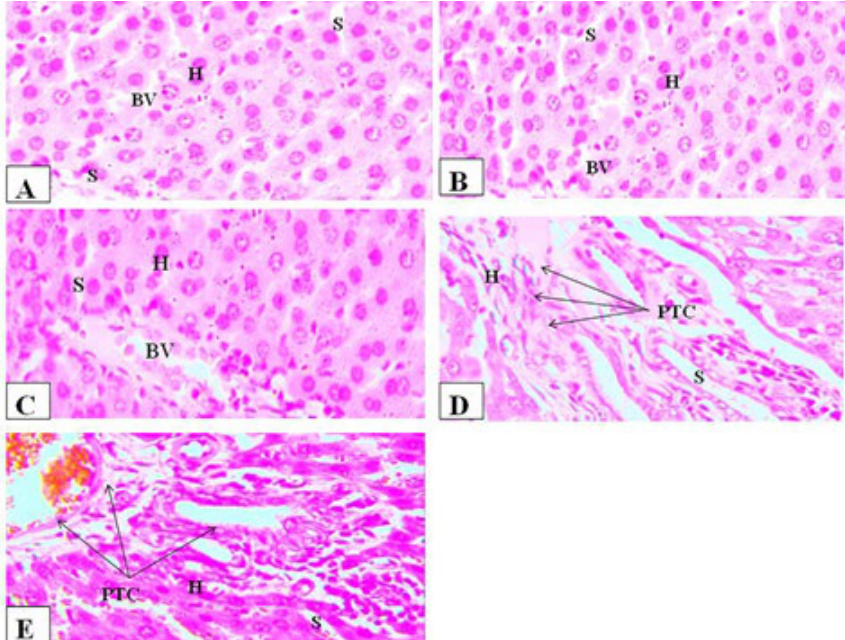
FIGURE 1 - 91 st day liver sections photomicrographs showing; Plate A (Control), Plate B (62.5 mg/kg), Plate C (125 mg/kg), Plate D (250 mg/kg), Plate E (500 mg/kg). H: Hepatocytes, BV: Blood vessel, S: Sinosoid. PTC : Portal triad congestion).